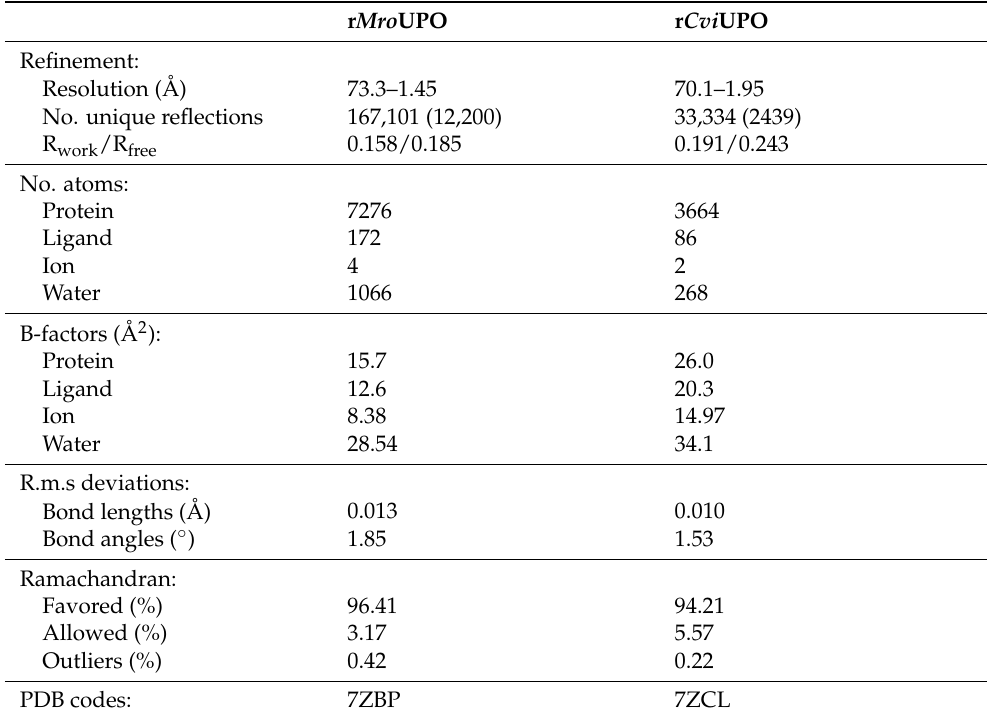
Table 2. Refinement